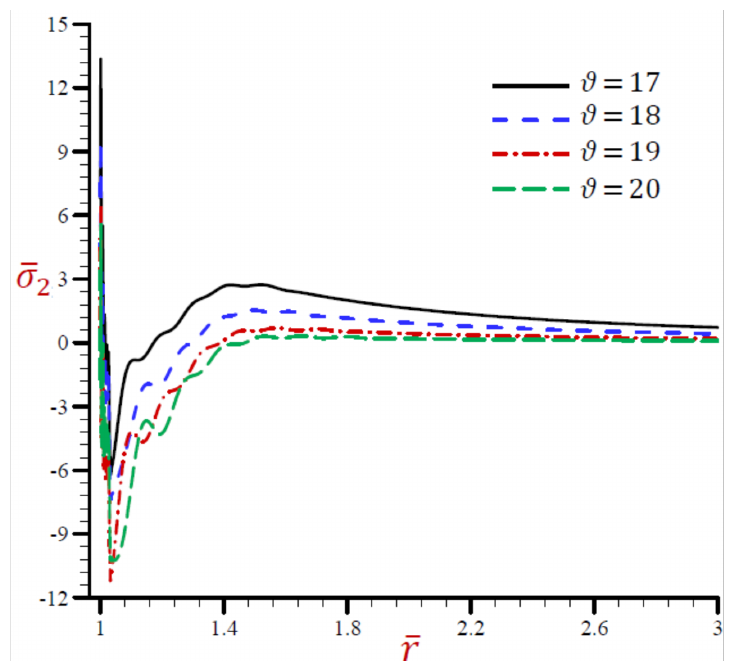
Figure 17. Effect of ϑ on radial stress σ 2 across the radial direction of the cylindrical cavity utilizing the RDPL